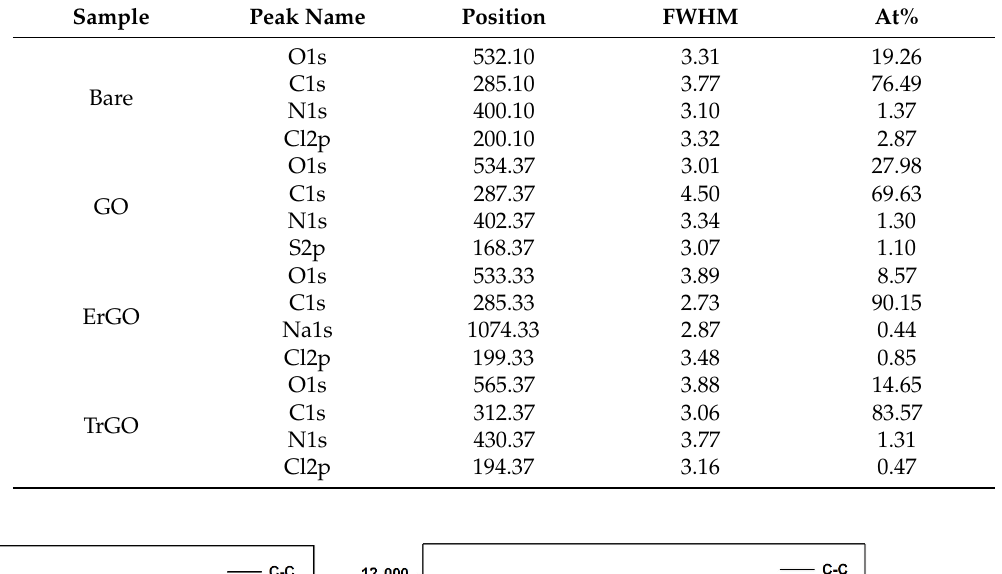
Table A1. Detailed information of the XPS peaks, their positions, the FWHM, and the At% for a bare electrode and for the electrodes modified with GO, ErGO, and TrGO. These data are obtained from the XPS survey scans (Figure 2).